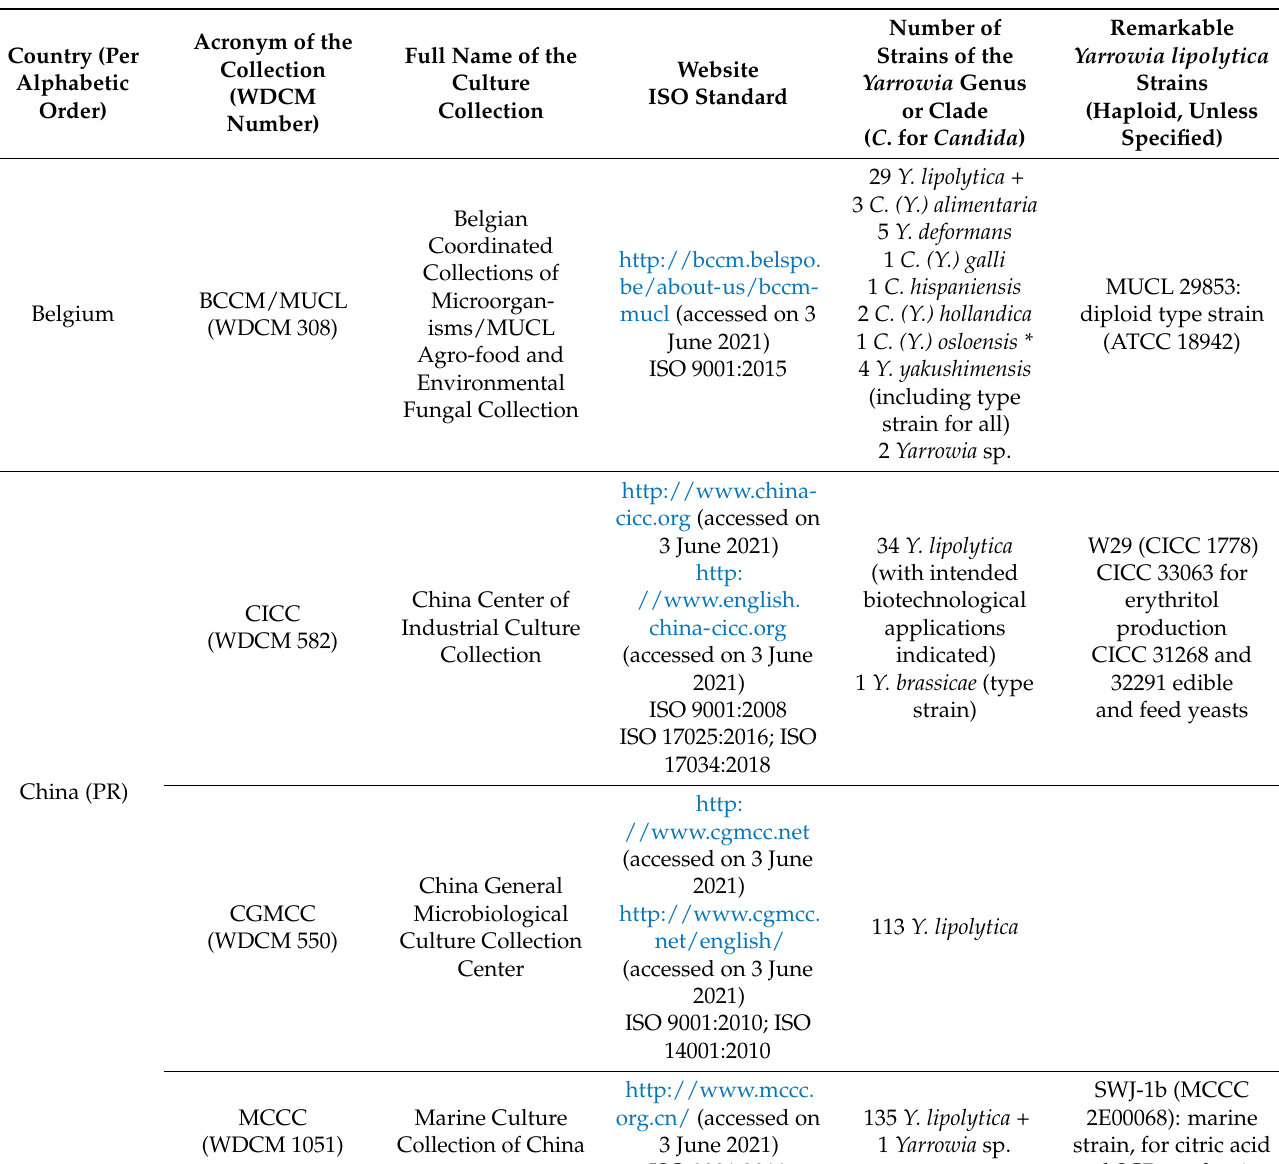
Table 2. Main yeast culture collections proposing an important catalogue of publicly available strains of the Yarrowia genus or